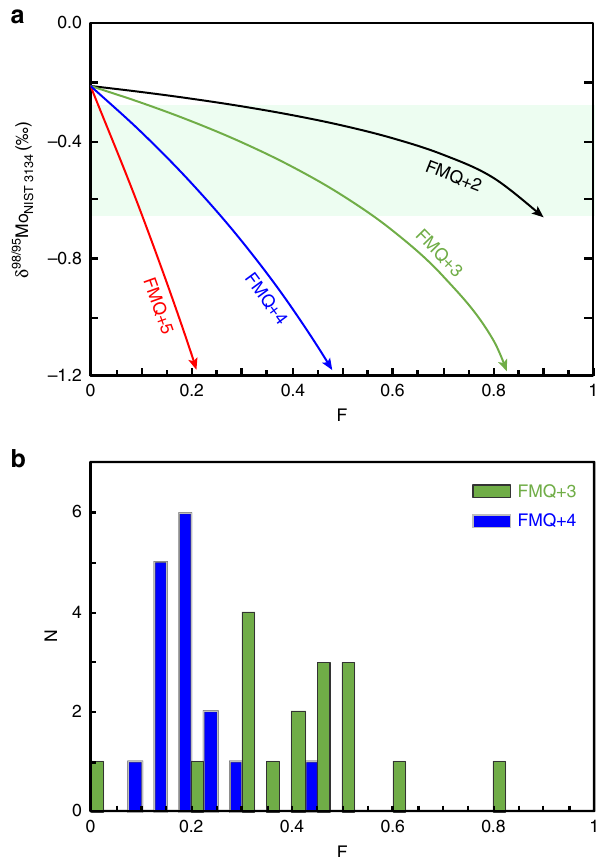
Fig. 3 Modelled variations in Mo isotope composition as a function of mass fraction of fl uid removed (F). a Results of the same model as in Fig. 2, but for different oxygen fugacities. Solid band represents the average δ 98/ 95 Mo NIST 3134 ± 1 SD of eclogites and blueschists. b Histograms of modelled fractions of fl uid removed, calculated for eclogites and blueschists (at two different oxygen fugacities) to illustrate the range of fl uid loss required to account for their observed δ 98/95 Mo NIST